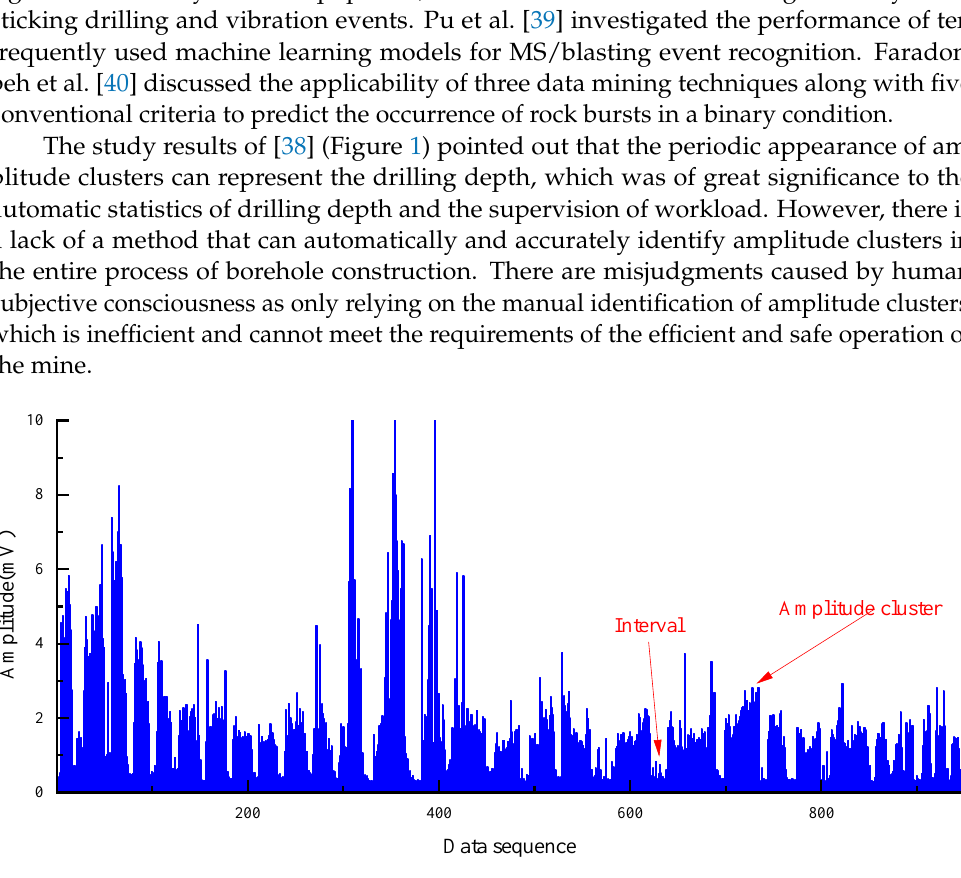
Figure 1. Amplitude clusters and intervals in amplitude data during drilling.